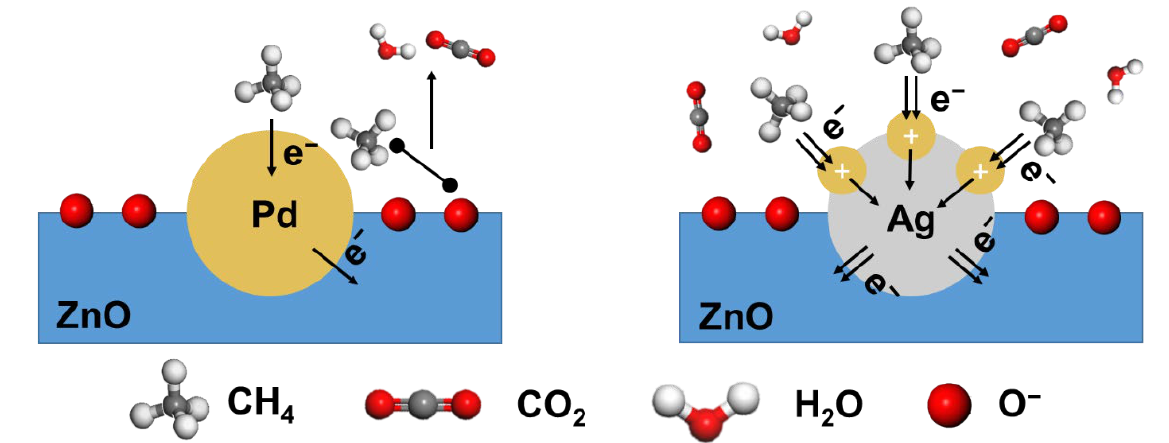
Figure 9. The mechanism for the enhanced sensing performance of CH 4 by the Ag@Pd structure.